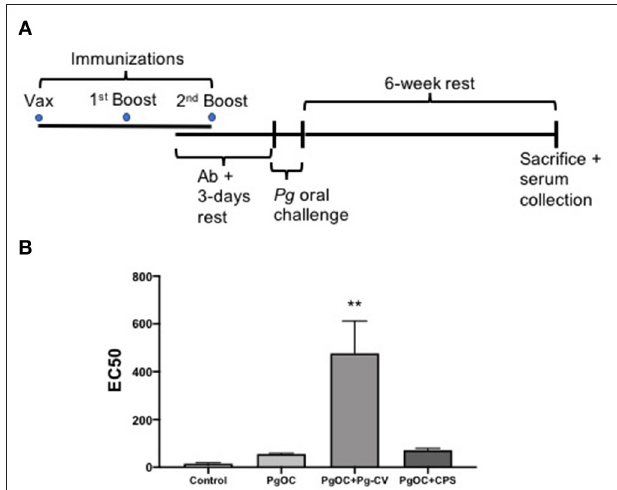
FIGURE 2 | Pg-CV elicits a potent P. gingivalis whole organism-specific IgG host response. (A) A timeline of animal studies. Groups of animals ( n = 10/group) did not receive injection or were immunized with Pg-CV or purified P. gingivalis CPS by intramuscular immunization three times in a 4-week period. Following oral antibiotic administration (Ab), animals were challenged orally three times in a 1-week period with P. gingivalis strain A7436 in 2% carboxymethylcellulose. Mice were humanely sacrificed 6 weeks later, sera were collected, and oral bone loss was assessed, using digital microscopy; (B) EC50 values of groups at sacrifice were determined based on initial dilution of harvested serum from pooled group samples (2–3 samples/pool, n = 4 pools/group); ** P < 0.01 vs. Control, PgOC, and PgOC + CPS by ANOVA, using Tukey post-test (no other comparisons were